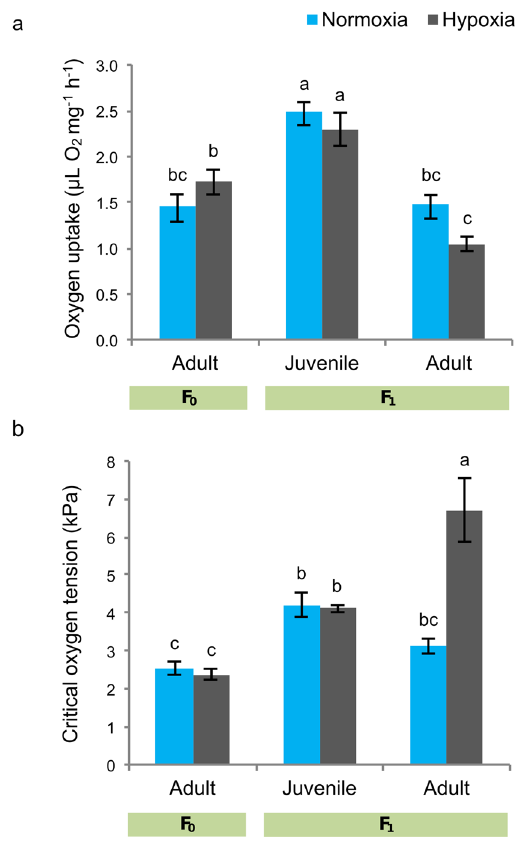
Figure 2. Chronic responses of juveniles and adult Gammarus chevreuxi to moderate hypoxia. ( a ) Mass- specific rates of O 2 uptake under acutely declining PO 2 and ( b ) critical PO 2 (or P c ) of F 0 adults (n = 6), F 1 juveniles (n = 5) and F 1 adults exposed to normoxic (100% air saturation) and hypoxic (40% air saturation) conditions. Individuals from the F 1 generation were bred from parents exposed to the same treatment as their offspring, and reared under the same conditions. Values are expressed as mean ± s.e.m. Letters above bars indicate significant differences between groups ( P <